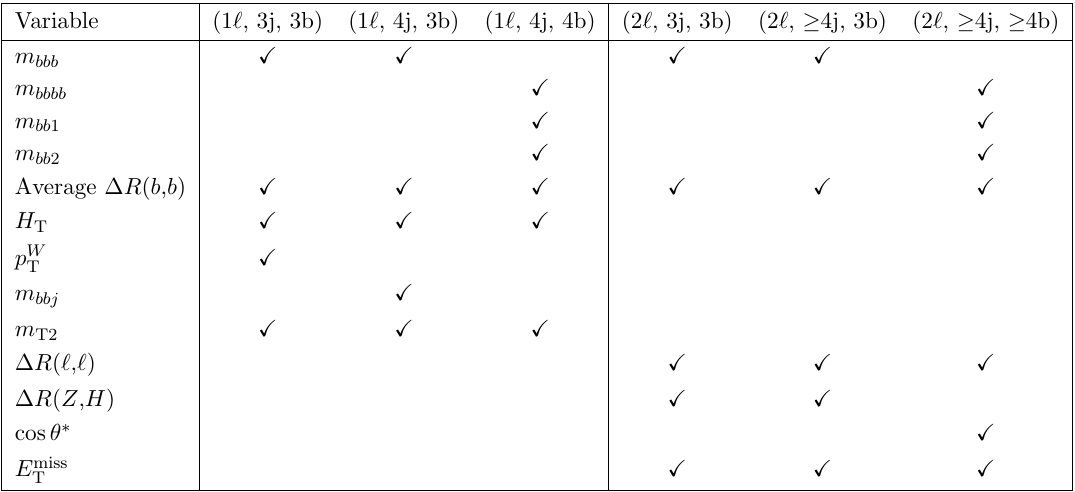
Table 2. List of variables used to train the BDT multivariate discriminant for each signal region. a (cid:28) -lepton decay or from a lost jet from a W boson. In these cases, m at the top-quark mass, which is not the case for the